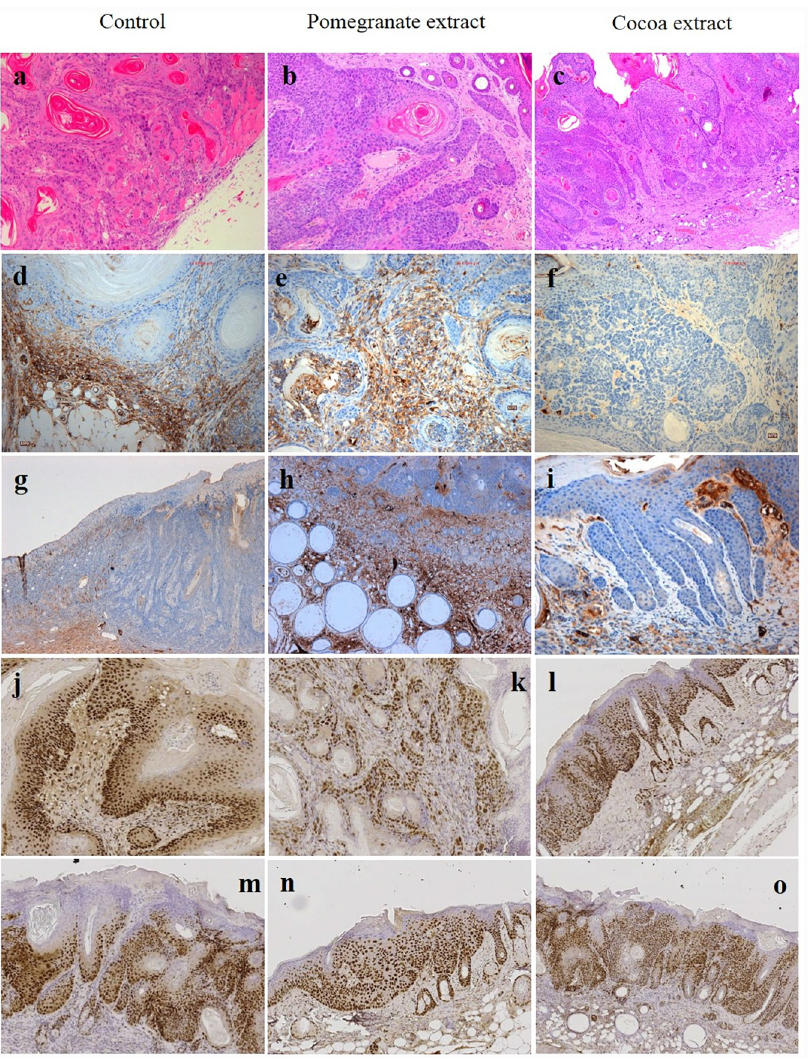
Fig 5. Spinocellular carcinomas in the different study groups (Haematoxilin-eosin) (a,b,c); MMP and TIMP-1 expression in surrounding tumour stroma (d, e, f and g, h, i respectively); p53 (j, k, l) and PCNA (m, n, o)